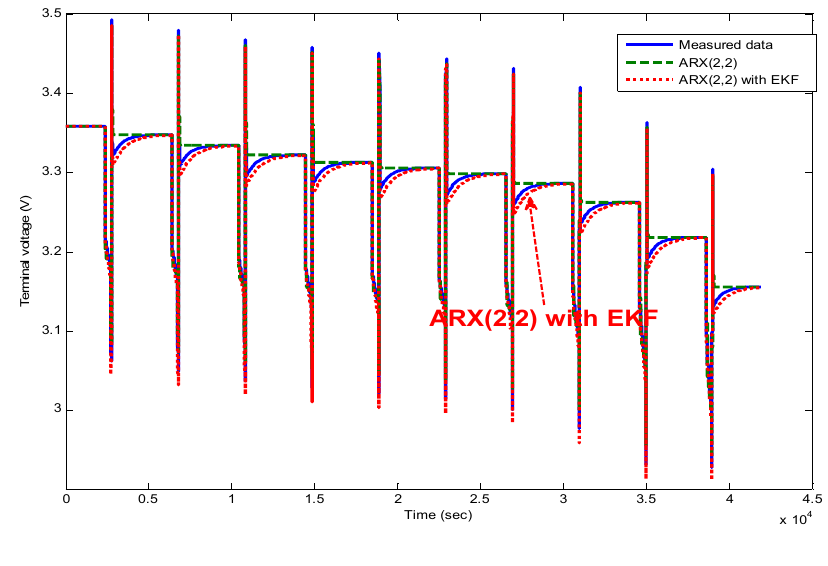
Figure 20. ARX (2,2) model voltage vs. ARX(2,2) & EKF model